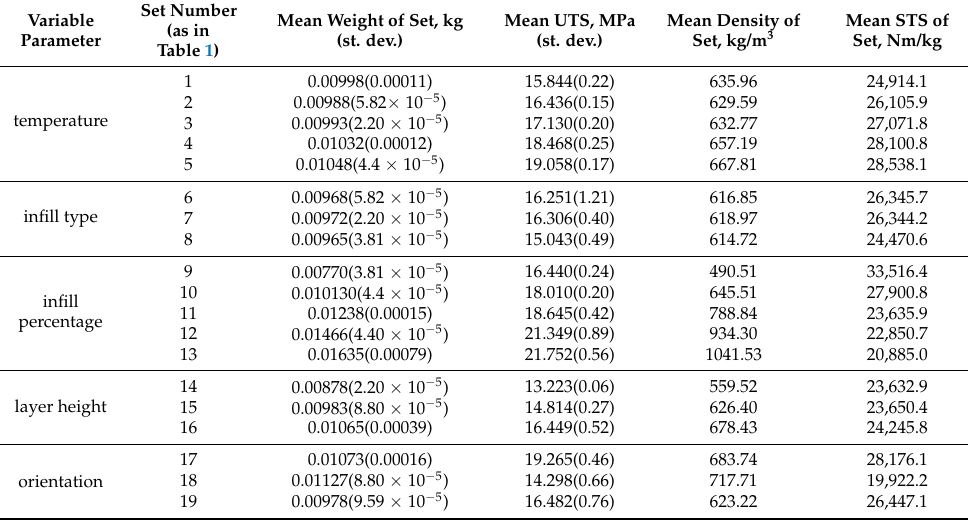
Table 2. Test results for PET-G